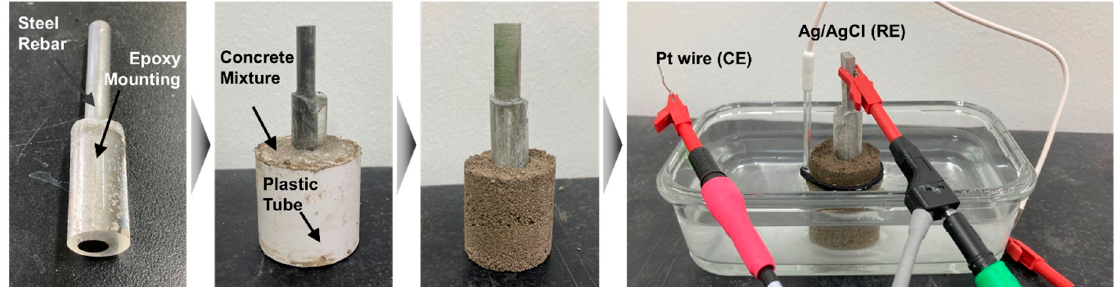
Figure 1. The preparation procedure of the sample and the electrochemical cell (i.e., reference electrode (RE) and counter electrode (CE)) for the corrosion test. Table 1. Chemical composition (in wt.%) of S400 and FSMA 1 . Table 2. Test conditions for corrosion resistance of FSMA 1 and S400 in concrete.